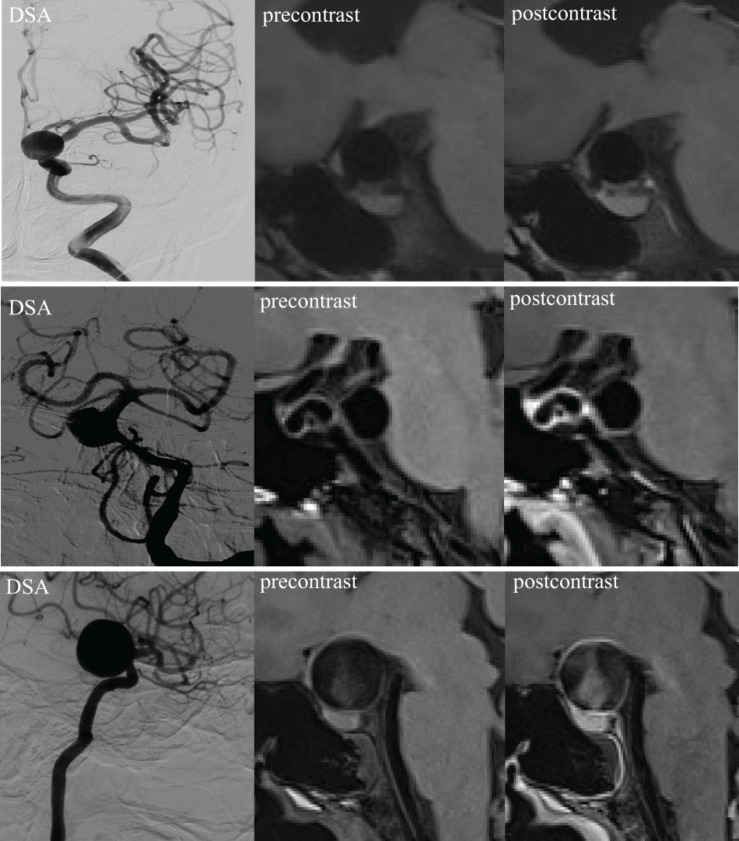
3D high-resolution MRI demonstrating an aneurysm wall without enhancement (pattern 0, first row), focal enhancement (pattern 1, second row), and circumferential enhancement (pattern 2, third row). DSA, digital subtraction angiography.